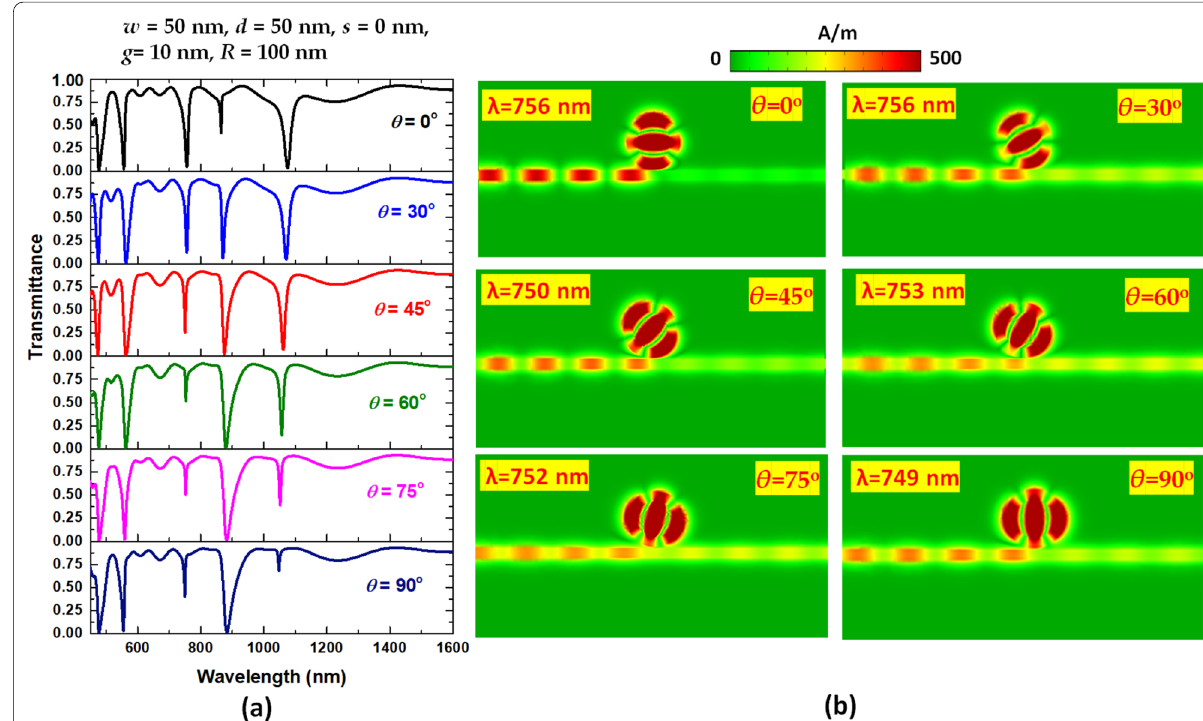
Fig. 5 Transmittance spectra of the case 3 structure with a variation of θ and b selected magnetic field (|H|) intensity at the corresponding λ res of mode 3